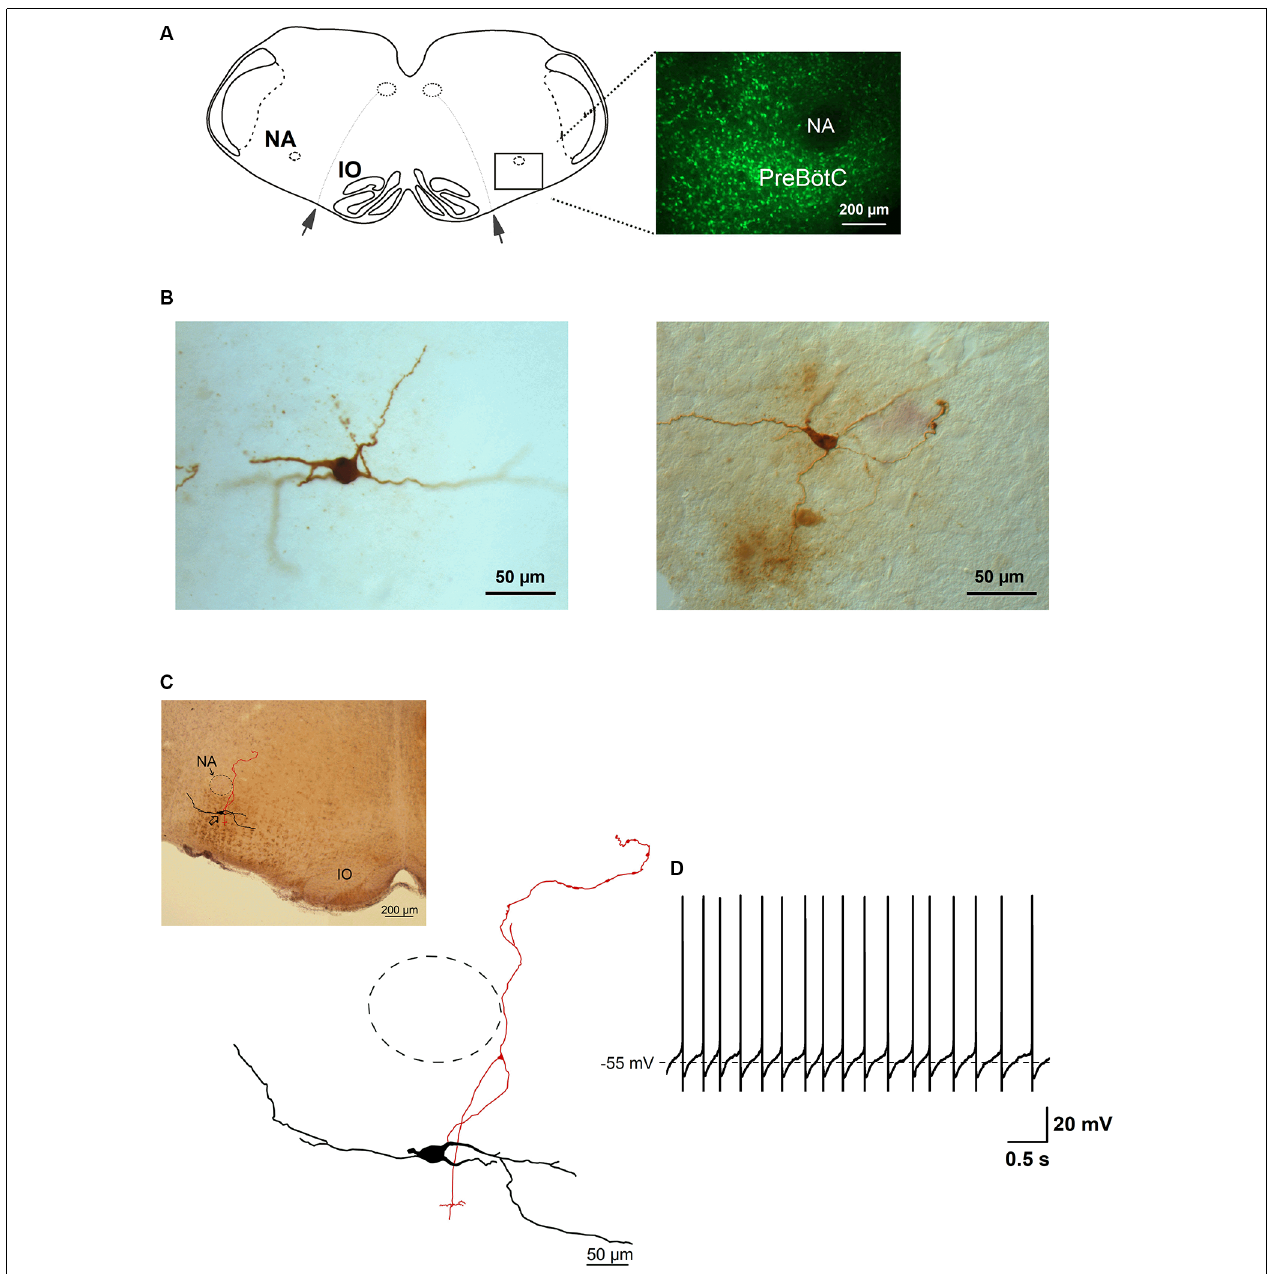
FIGURE 1 | Glycine transporter type 2 (GlyT 2 ) enhanced green fluorescent protein (EGFP)-positive neurons in the preBötzinger complex (preBötC). Panel (A) is a schematic drawing of a brainstem slice showing the location of the preBötC. Nucleus ambiguus (NA), inferior olive (IO) and the rootlets of n. XII (arrows) are used as landmarks. The fluorescent micrograph (60 µ m thick) on the right shows the distribution of EGFP-positive neurons and the location of the preBötC ventral to NA, which itself is free from EGFP label. (B) Two examples of light micrographs of biocytin-labeled neurons (60 µ m thick sections). Panel (C) shows a reconstructed drawing of a biocytin-filled neuron, which is a projection of five consecutive sections (60 µ m), re-cut from the slice (350 µ m) after electrophysiological recording. The upper-left micrograph illustrates the location of the neuron. The approximate location of NA is indicated by the dashed circle. (D) This membrane voltage trace shows the spontaneous discharge pattern of the neuron depicted in (C) , recorded in whole-cell current-clamp in physiological external potassium and with GABAergic synaptic inhibition blocked.